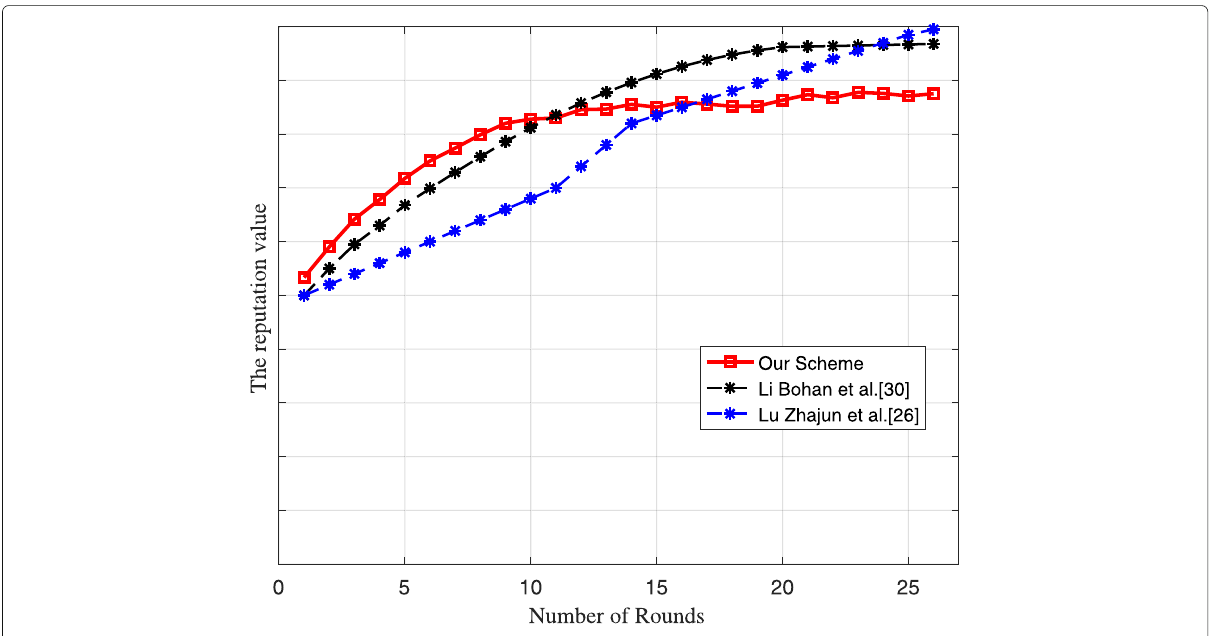
Fig. 6 The reputation value tendecy of honest nodes compare with [26] and [30]